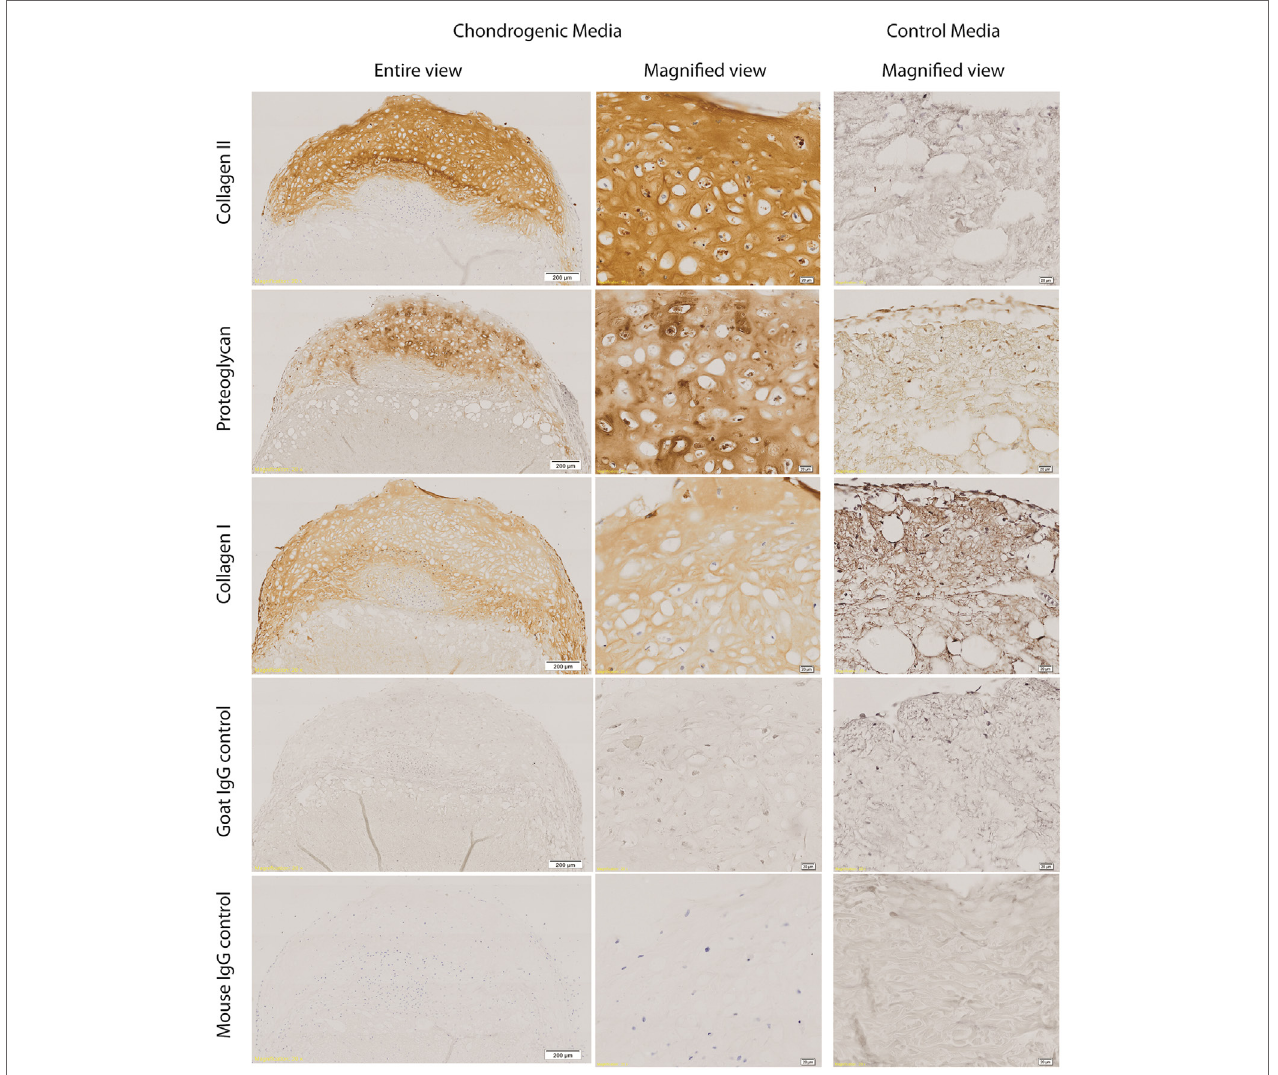
FigUre 4 | immunohistochemistry of cell-aDM constructs. Representative figures of immunohistochemical staining of week 4 chondrogenic and control IPFP-ASCs–ADM constructs for collagen Type II and proteoglycan staining of the cartilaginous cap. There was diminished collagen Type II staining within the zone of interaction and no staining within the ADM. Collagen Type I was detected throughout, as well as within the ADM. However, there was weaker collagen Type I staining centrally within the cartilaginous cap compared with the periphery and the ADM-cell interaction zone. All isotype control staining were negative. Scale bars as indicated. Magnification: 10 ×